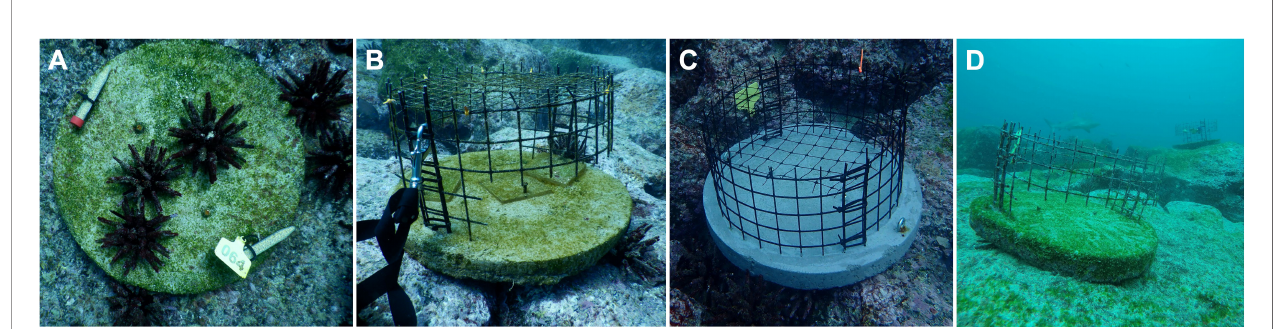
FIGURE 2 | Examples of the four types of experimental pizzas used. (A) Open pizzas with full access to all grazers. (B) Fish exclusions, which allowed access only to sea urchins (shown acrylic plates were used only during the pilot phase of this study). (C) Full exclusions, preventing access to all macro-herbivores such as sea urchins, fi shes, iguanas, and turtles, but not to meso-herbivores such as amphipods. Note the clean, uncolonized experimental surface immediately after deployment. Both cages ( fi sh and full exclusions) are covered with a fi ne, 1cm mono fi lament mesh top. (D) Procedural control that included partial sides, designed to affect fl ow and light to a similar degree as other cages to test for experimental artifacts of the herbivore manipulation. Pizzas on (A – C) were used in the cool season experiment, pizzas on (A, C, D) in the warm season experiment. Results of (D) are shown in Supplementary Figure 2 . The pizza design is based on Witman et al. (2017). Note the huge Gala ́ pagos shark cruising across the reef in (D)